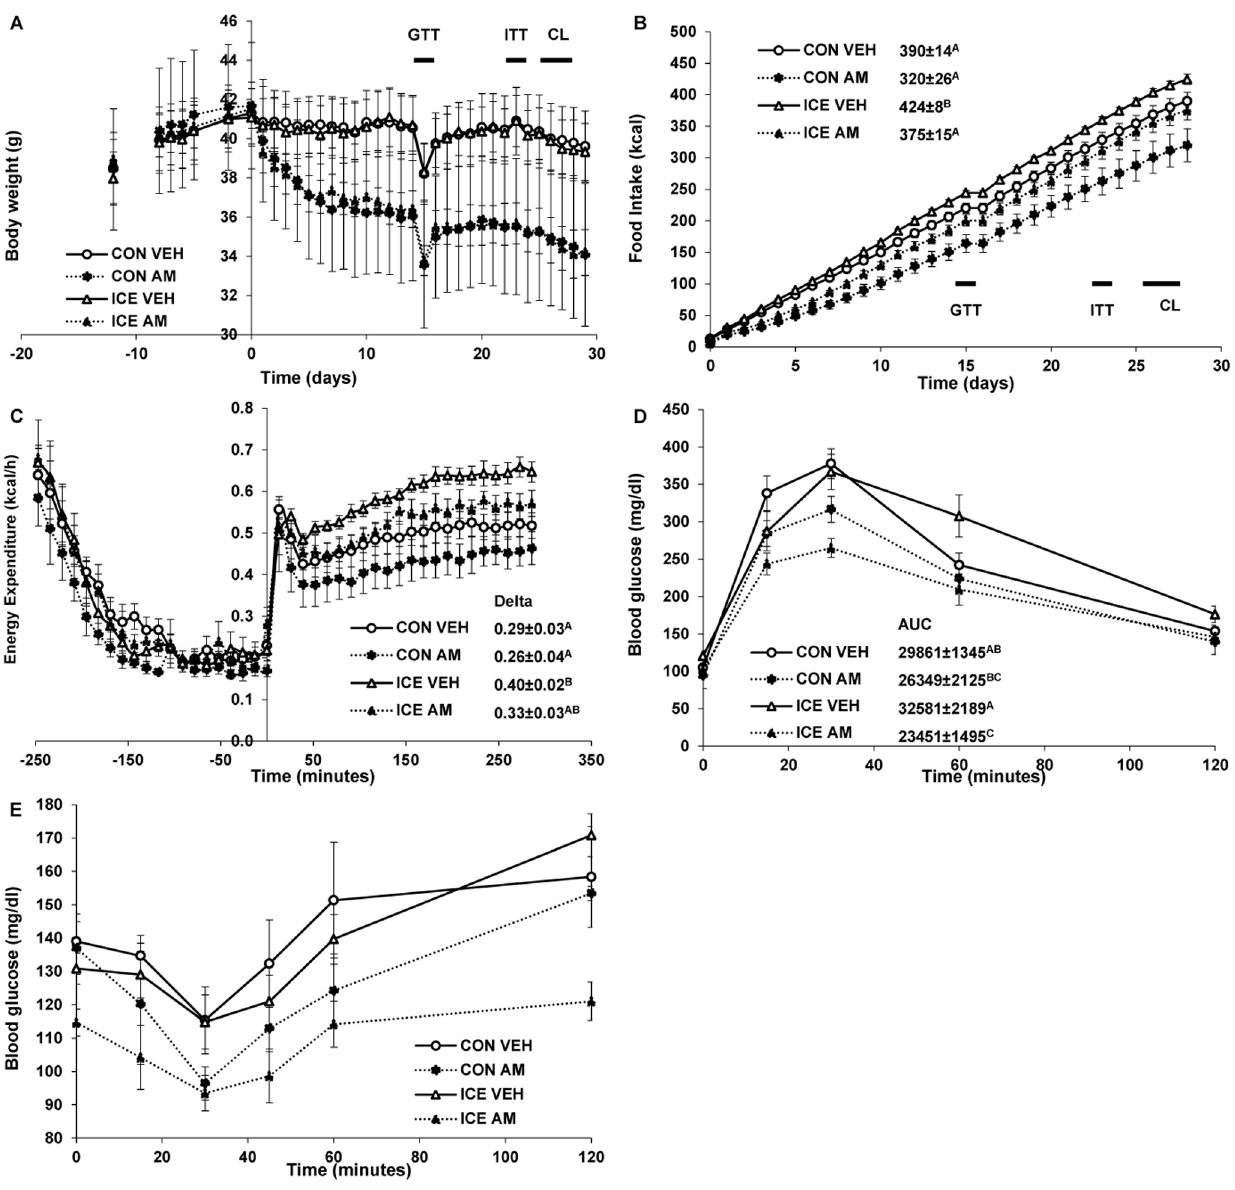
Figure 4. Effects of AM251 and cold exposure. Mice were administered vehicle or AM251 (3 mg/kg/day) by oral gavage. A: Caloric intake and B: body weight were measured three times per week on days of cold exposure. C: Mice at 30 u C were administered CL316243 (100 m g/kg) at time 0 as described in Experimental Procedures (the prior AM251 was given at 2 24 hours). Inset shows the delta TEE, calculated as in Figure 2. 2-way ANOVA showed significant temperature (p , 0.01) and drug (p , 0.05) effects with no significant interaction (p=0.62). D: Intra-peritoneal glucose tolerance tests (1 g/kg) were performed in overnight-fasted mice of the indicated treatment group two days after cold exposure. AUC numbers are in mg/ dl . minute. E. Insulin tolerance test. Insulin (0.75 U/kg) was injected and blood glucose measured at the indicated times. GTT= intraperitoneal glucose tolerance test. CL= CL316243 experiment. ITT= insulin tolerance test. AM251 was administered 24 h prior to the GTT and ITT. In D & E, a poor-responding outlier in the CON AM group was removed from the analysis. If included in the ipGTT AUC, this group’s AUC is 29304 6 3382 mg/dl min and the CON AM significantly different from the ICE AM group. All data are mean 6 SE. N=6/group. Levels not connected by same letter are significantly different (P ,